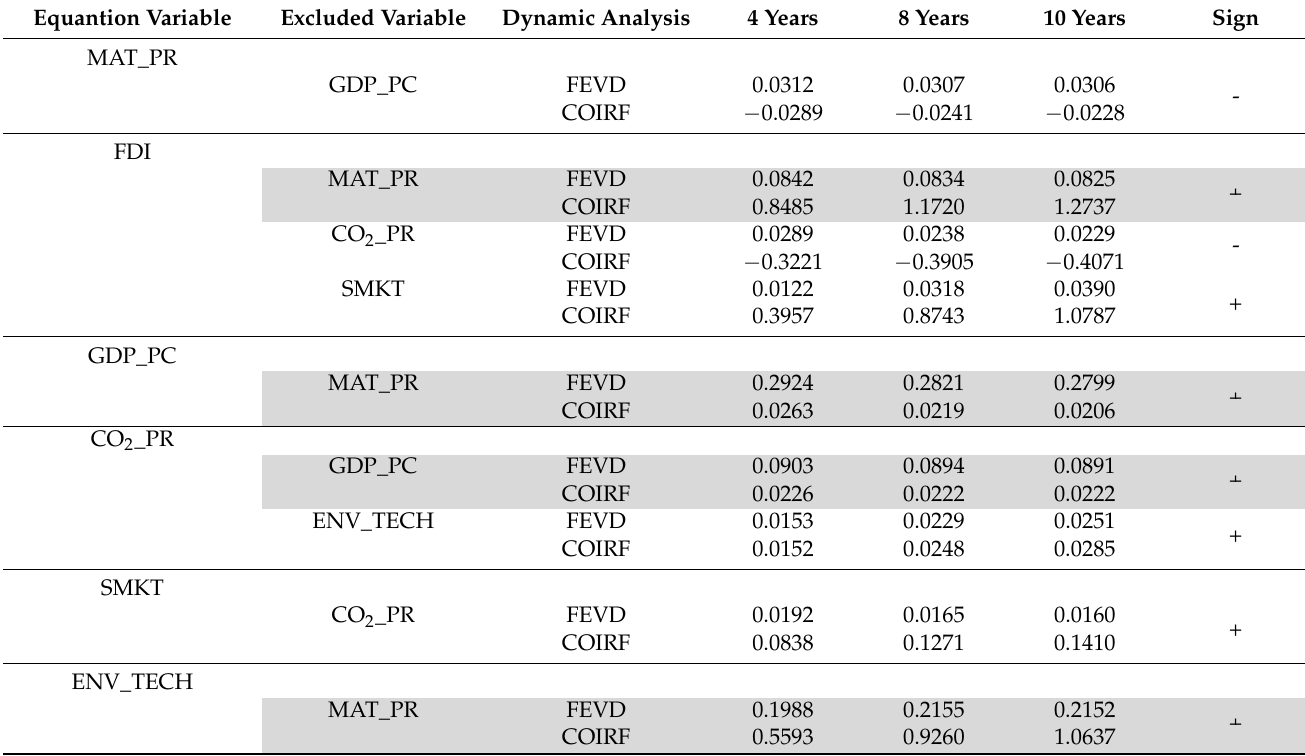
Table 4. Analysis of causality and amplitude relationships in the Global Group.